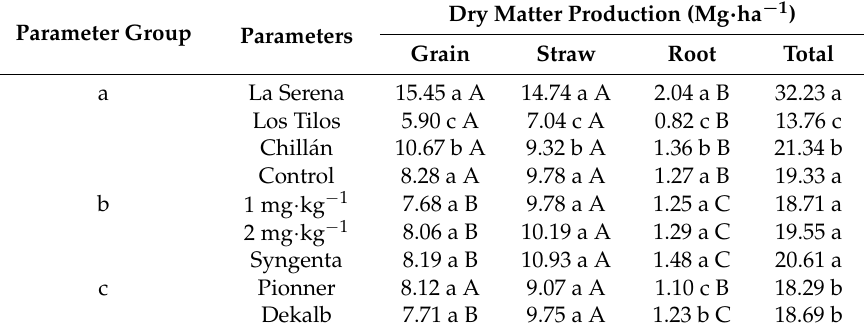
Table 4. Dry matter production (Mg · ha − 1 ) according to maize plant parts for: (a) different study environments; (b) CdCl 2 rates; and (c) maize